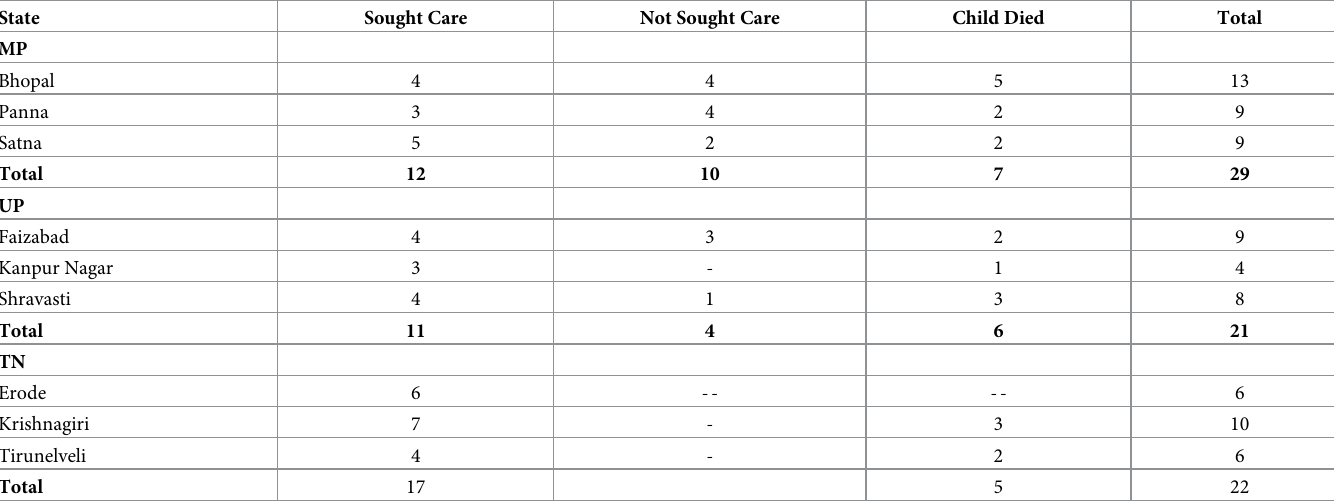
Table 2. Number of qualitative interviews by stakeholder